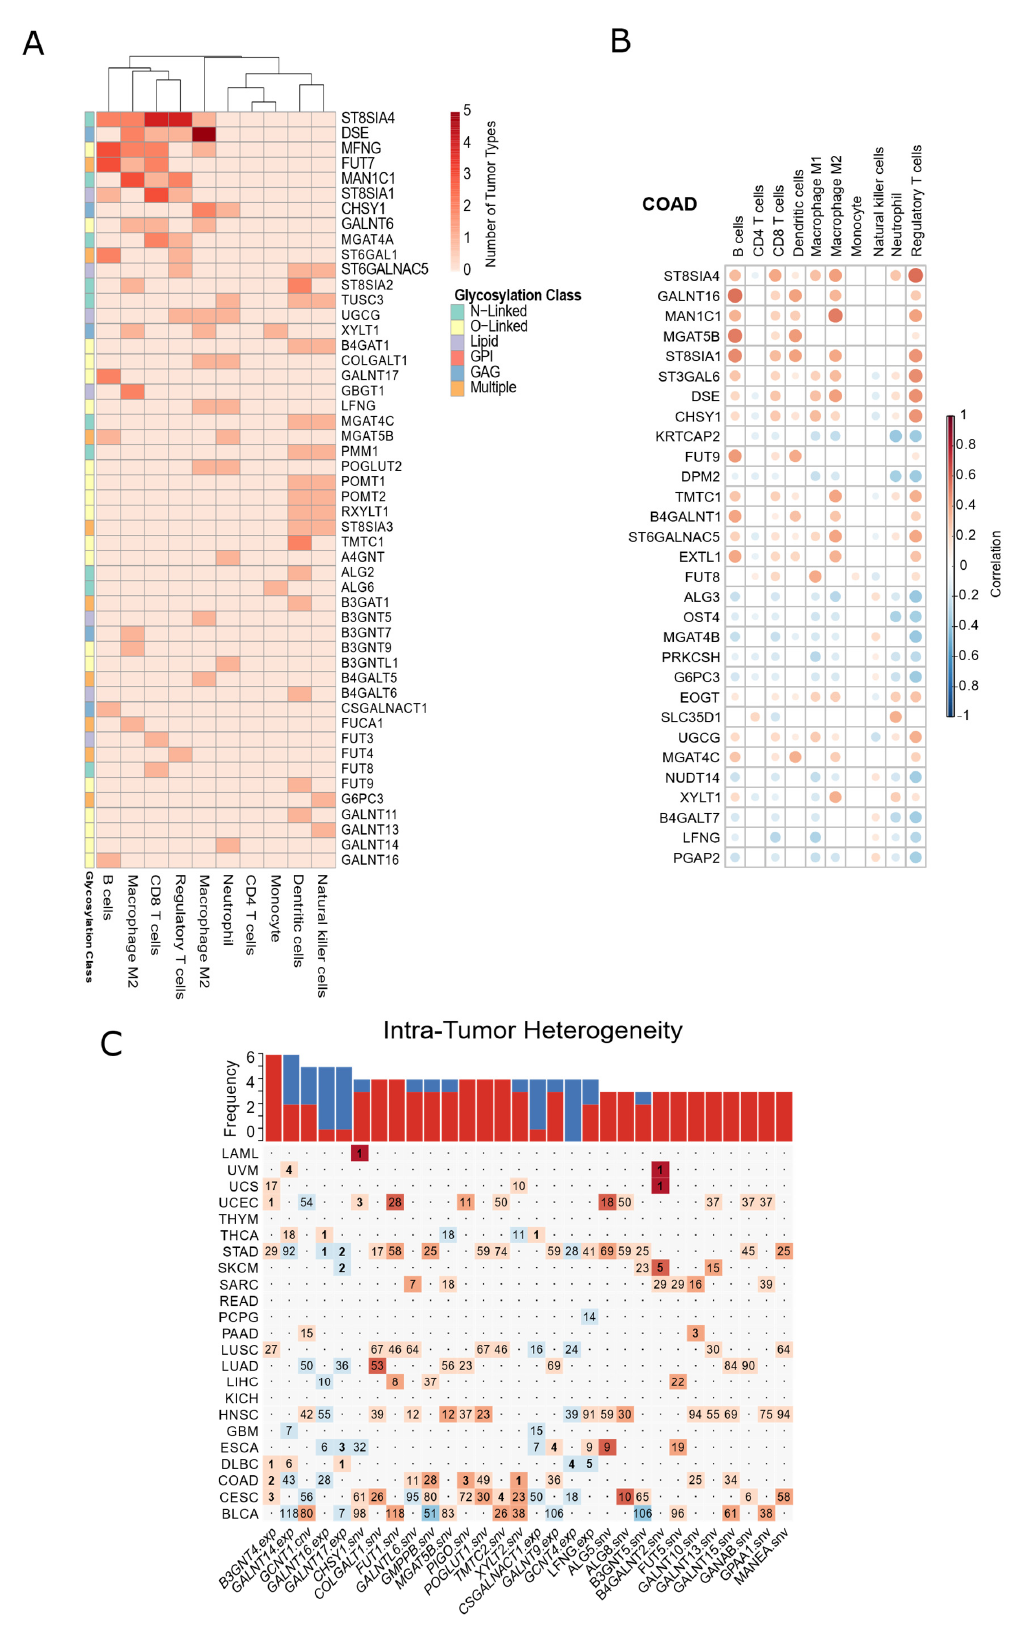
Figure 6. Glycosylation Factors have prognostic value in cancer. ( A ) Heatmap representation of the number of TCGA cancer types where there is a significant correlation (FDR < 0.05) between